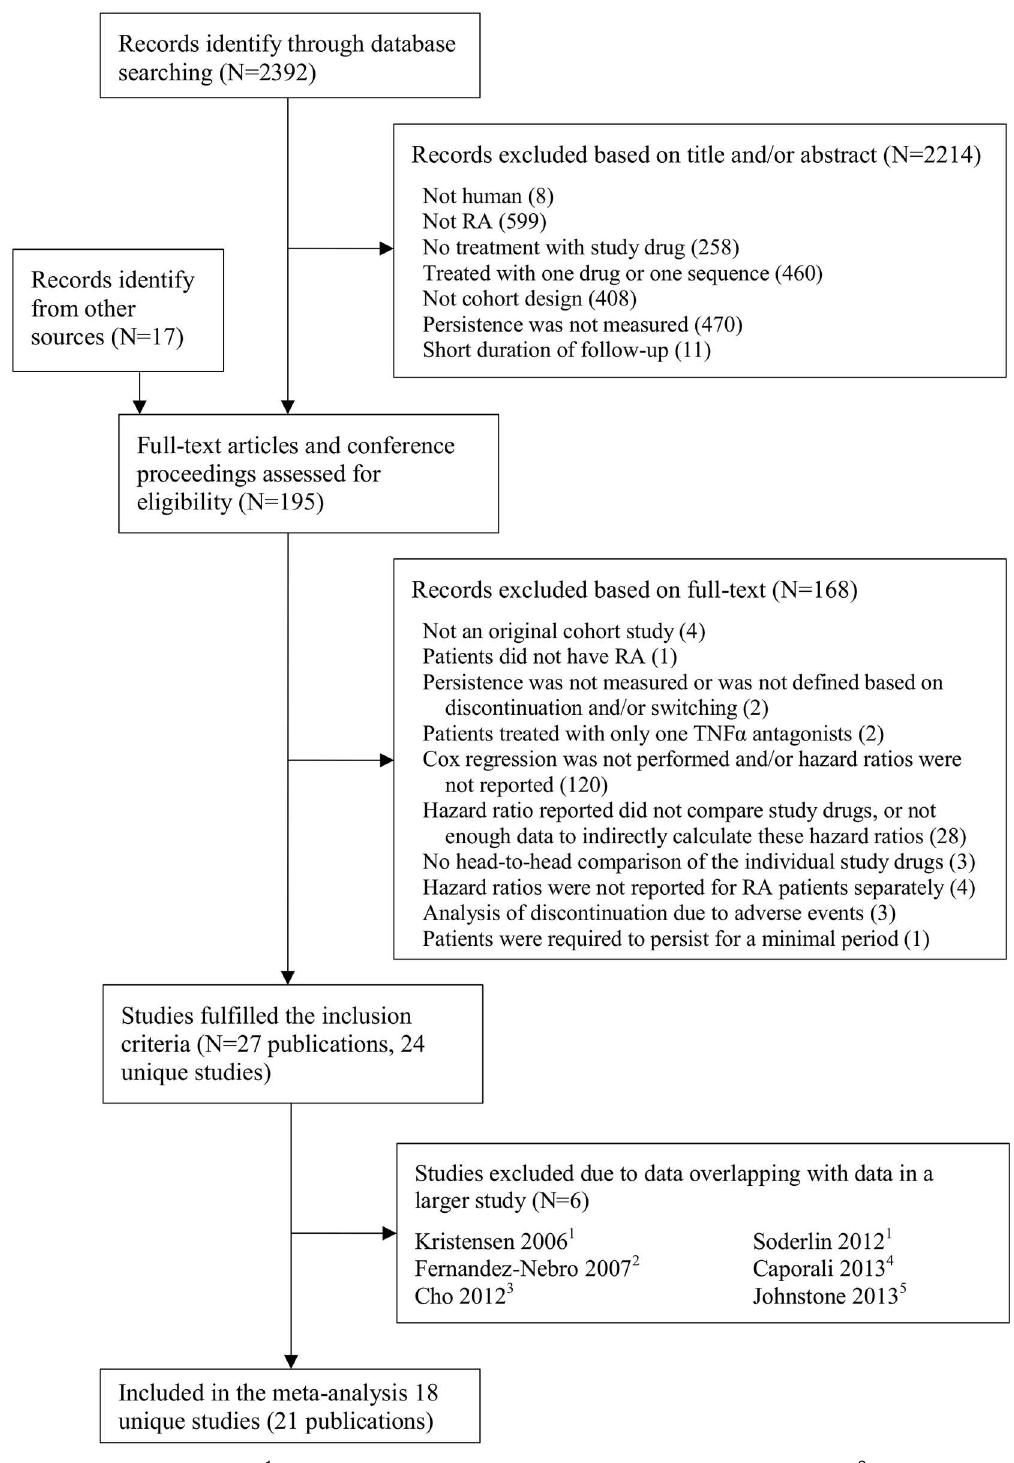
Fig 1. QUOROM flow chart. 1 SSATG is part of ARTIS, data were overlapping with Neovius2015. 2 Carlos Haya hospitalis includedin BIOBADASER 2.0, data were overlapping with Gomez-Reino 2012. 3 Data from South Korea NIH, also known as Health InsuranceReviewand Assessment Service, were includedin Lee 2014. 4 Data from MonitorNet were includedin Scire 2013. 5 Data from MarketScan were includedin Johnstone 2015.